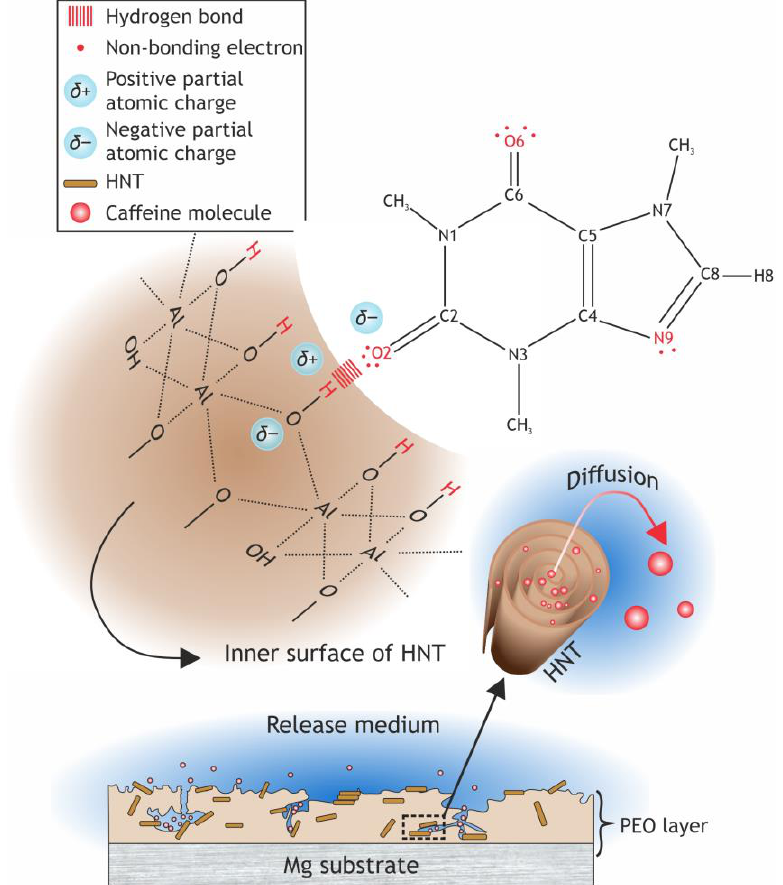
Figure 17. Interaction mechanism between HNTs lumen surface and caffeine.